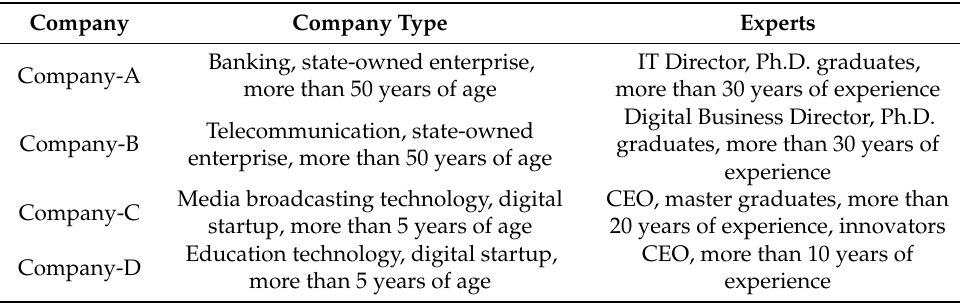
Table 1. Research Objects.